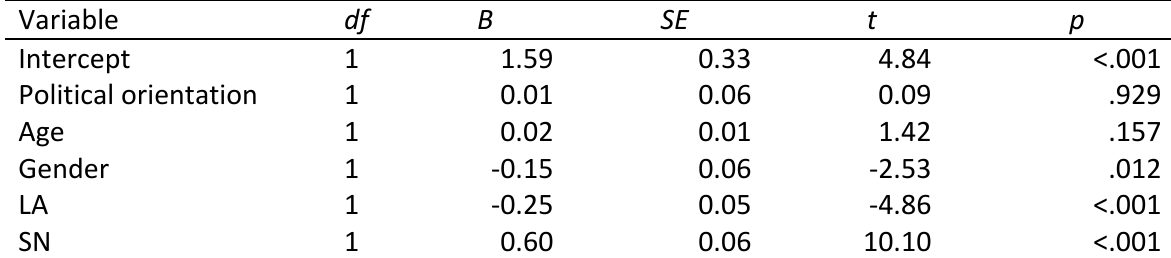
Regression Model Predicting FI from Political Orientation, Age, Gender, LA, and SN